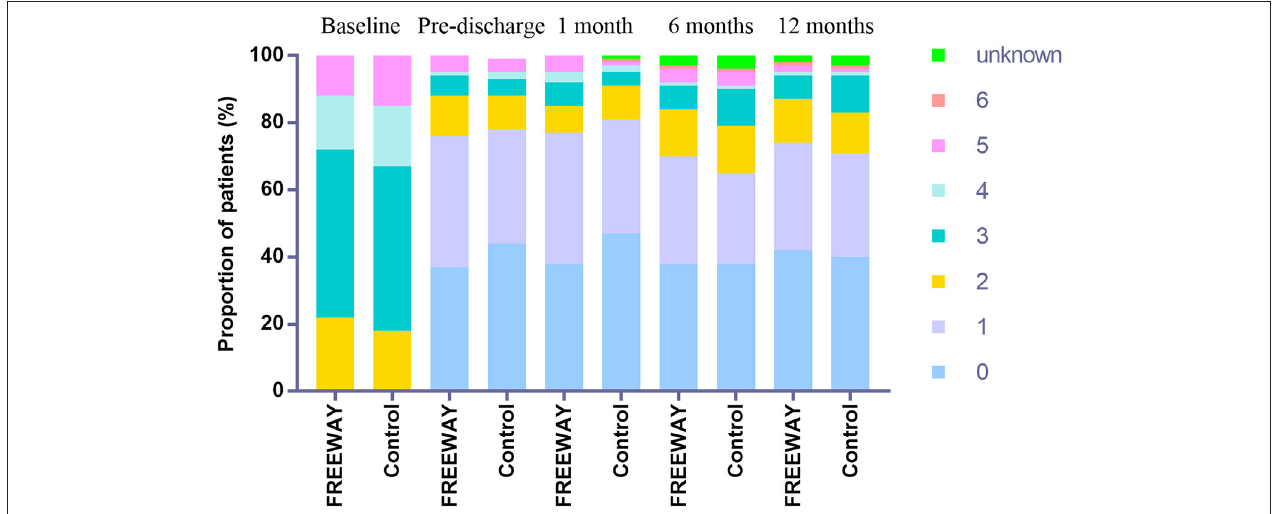
FIGURE 3 | Rutherford category distribution at baseline, before discharge, at 1, 6, and 12 months.